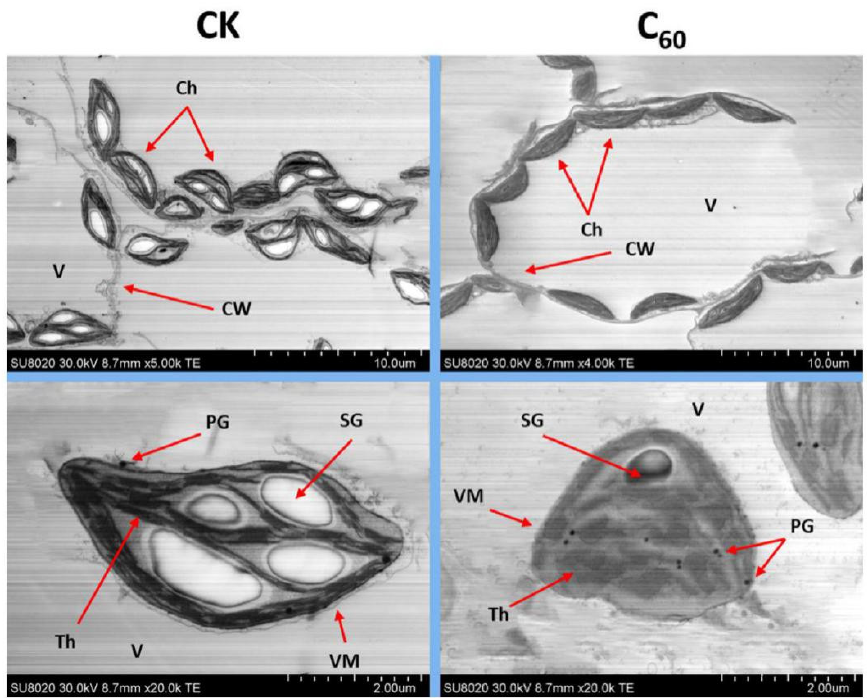
Figure 5. TEM observation of N. benthamiana leaf tissues that were infected by CCYV: GFP after foliar application of different MNOs at 100 mg/L. Ch, chloroplast; CW, cell wall; V, vacuole PG, plastoglobule; SG, starch granule, Th, thylakoid membraneand VM, vacuole membrane.